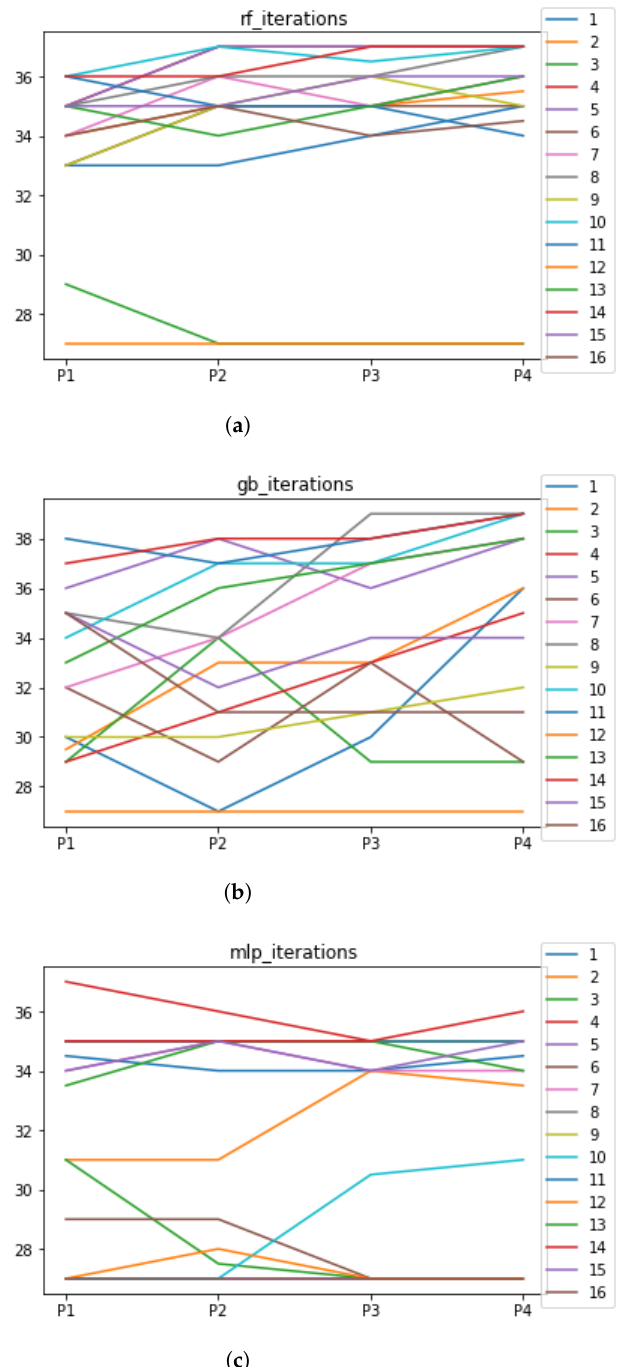
Figure 9. Number of iterations per partition. Each line represents a dataset (medians). ( a ) Number of iterations RF. In axis X, the partition of the dataset. In axis Y, the number of the iterations that RHOASo has carried out. ( b ) Number of iterations GB. In axis X, the partition of the dataset. In axis Y, the number of the iterations that RHOASo has carried out. ( c ) Number of iterations MLP. In axis X, the partition of the dataset. In axis Y, the number of the iterations that RHOASo has carried